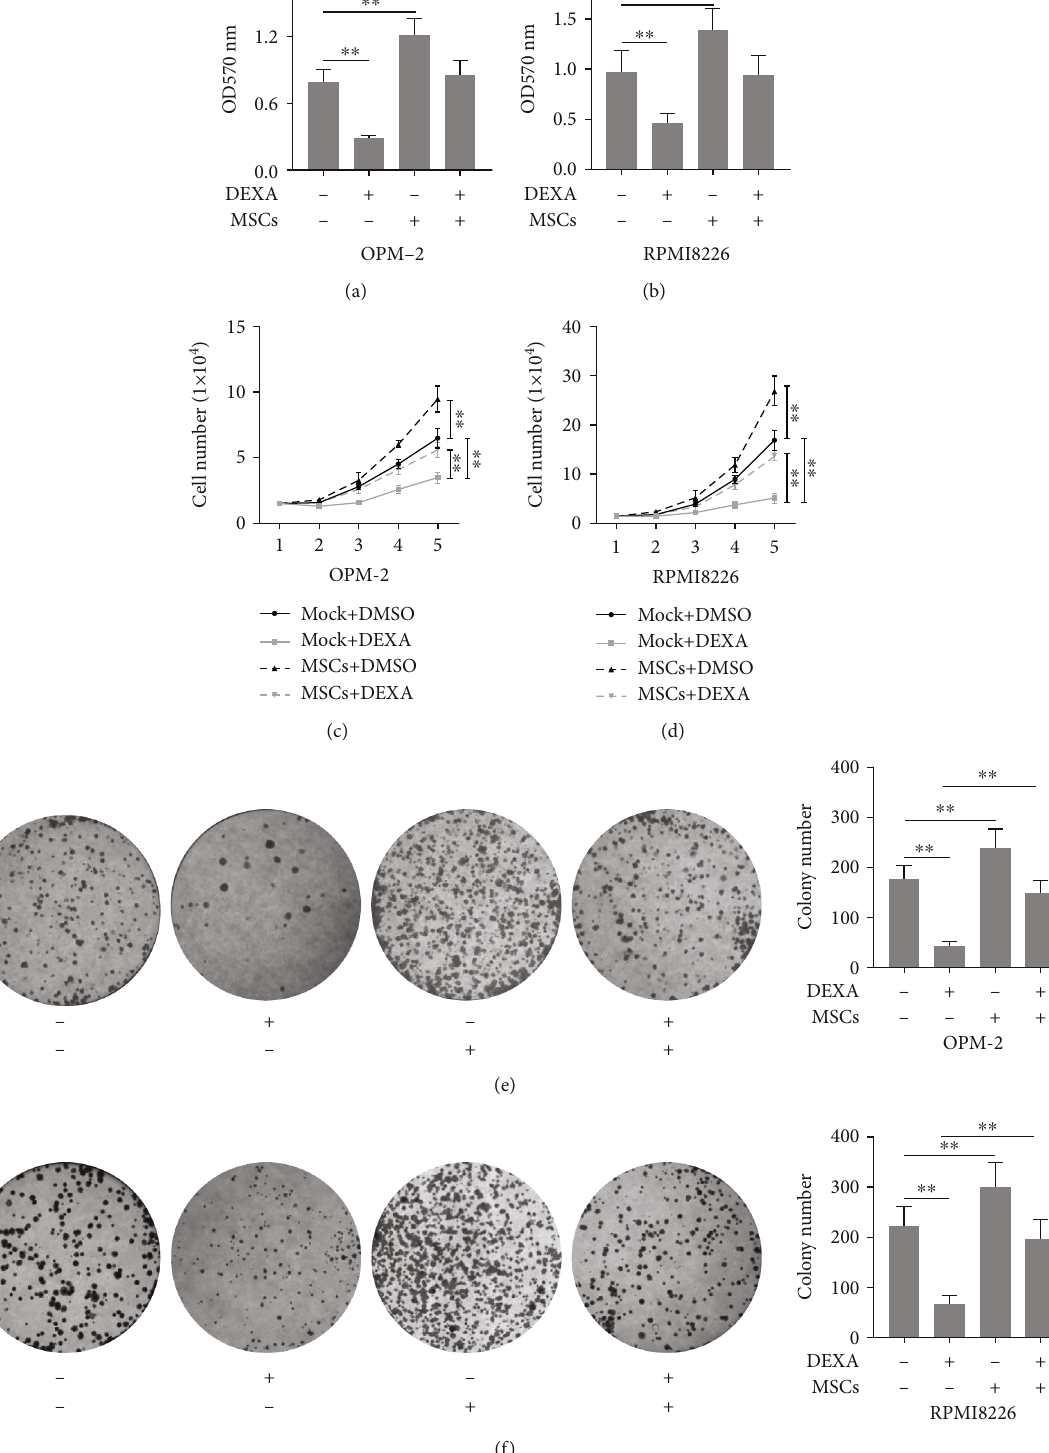
Figure 1: The presence of MSCs suppressed the inhibitory e ff ects of dexamethasone on cell proliferation. (a, b) The OPM-2 or RPMI8226 cells were cocultured with MSCs in a 6-well transwell microplate with or without dexamethasone (10 μ M). After 48 hours, cell viability was determined using the MTT assay. Besides, (c – f) cell number and colony formation assays were also determined on the OPM-2 and RPMI8226 cells. Mock indicates that the cells were transfected with a vector. One-way ANOVA for the data in (a), (b), (e), and (f). Two-way ANOVA for the data in (c) and (d). ∗∗ p < 0 : 01 and ∗∗∗ p < 0 : 001